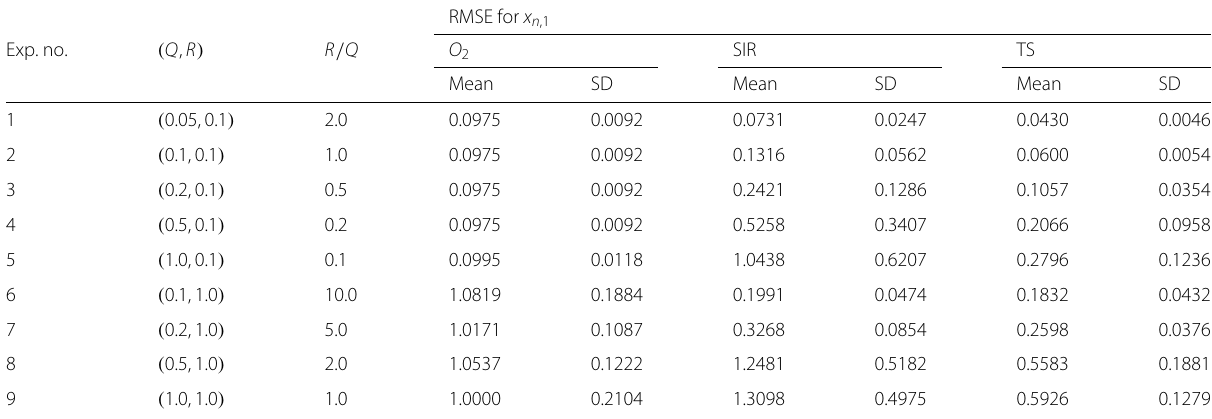
Table 7 Simulation results for Example 2: Mean and standard deviations of the RMSE for three different estimators of x n ,1 , namely, O 2 , the posterior mean based on SIR and the posterior mean based on TS Exp. no.